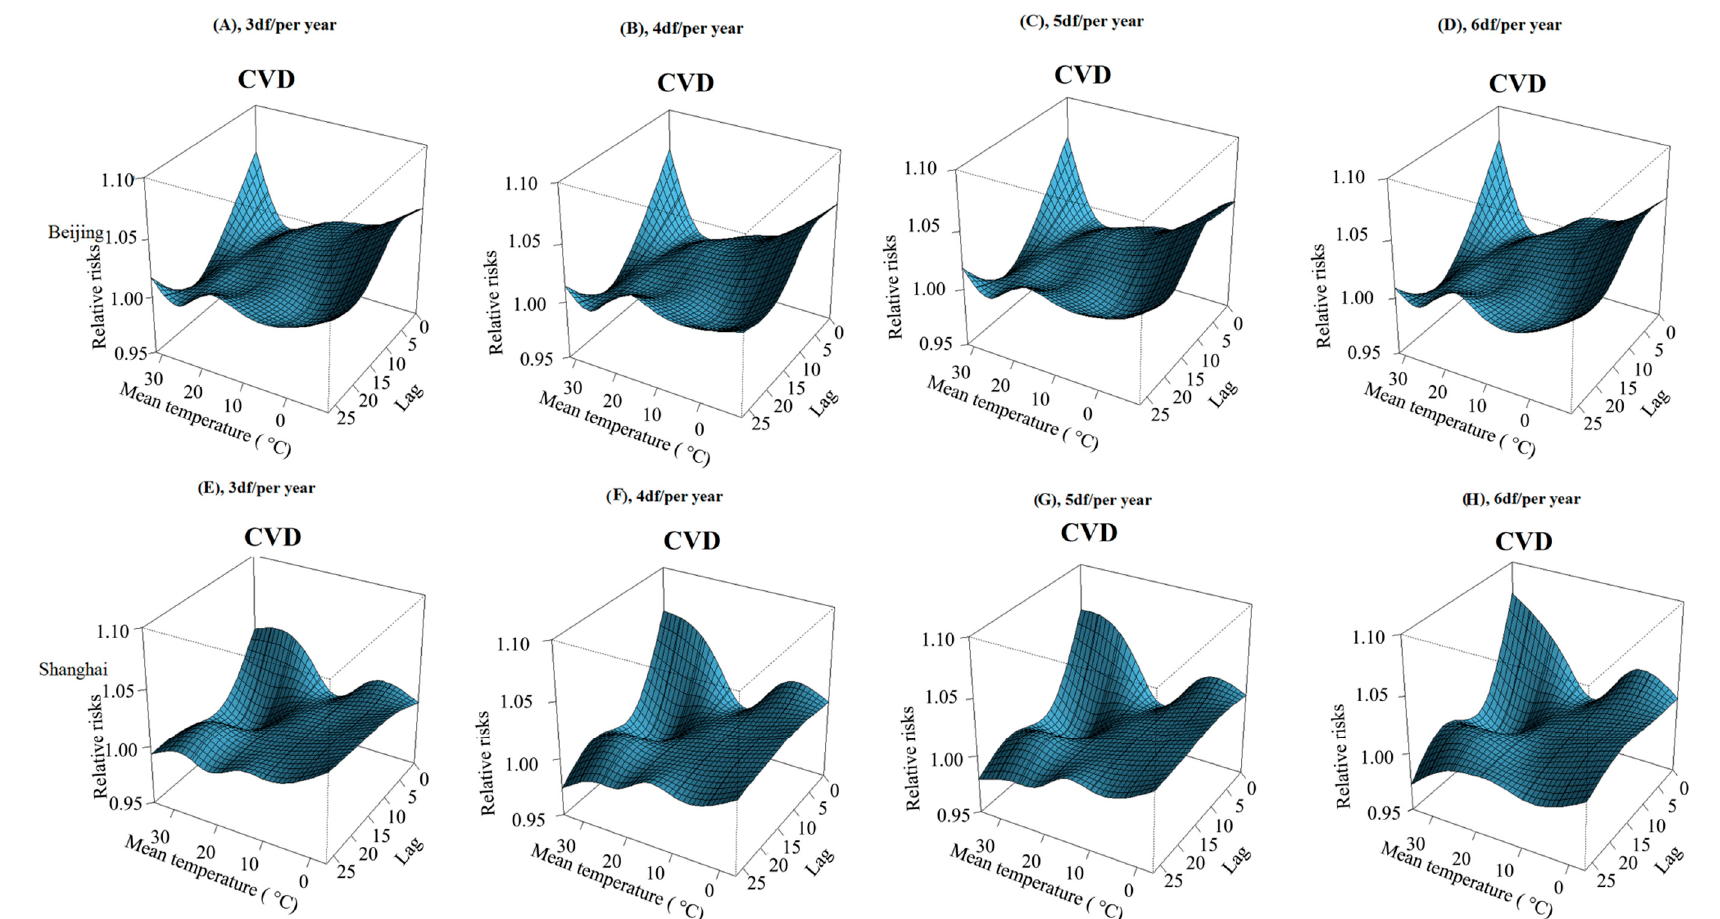
Figure A1. Three-dimensional graph of the relative risks for mortality from cardiovascular disease by temperature (°C) and lag days during 2007 and 2009 in Beijing and Shanghai, China. ( A – D ) Three to 6 degrees of freedom (df) per year for the time trend in Beijing, respectively; ( E – H ) Three to six df per year for the time trend in Shanghai, respectively.